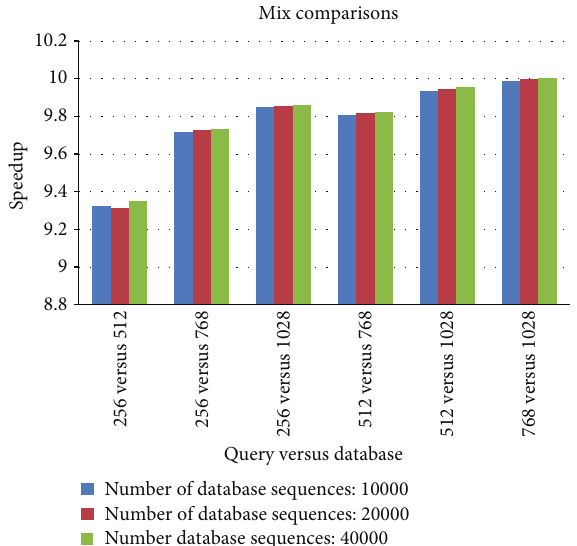
Figure 6: The overall speedup by comparing CUDA-SWfr with the CPU-based SW method for various